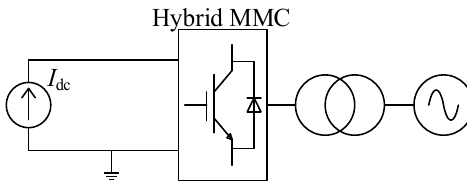
Figure 9. Schematic of the main circuit of the case study.